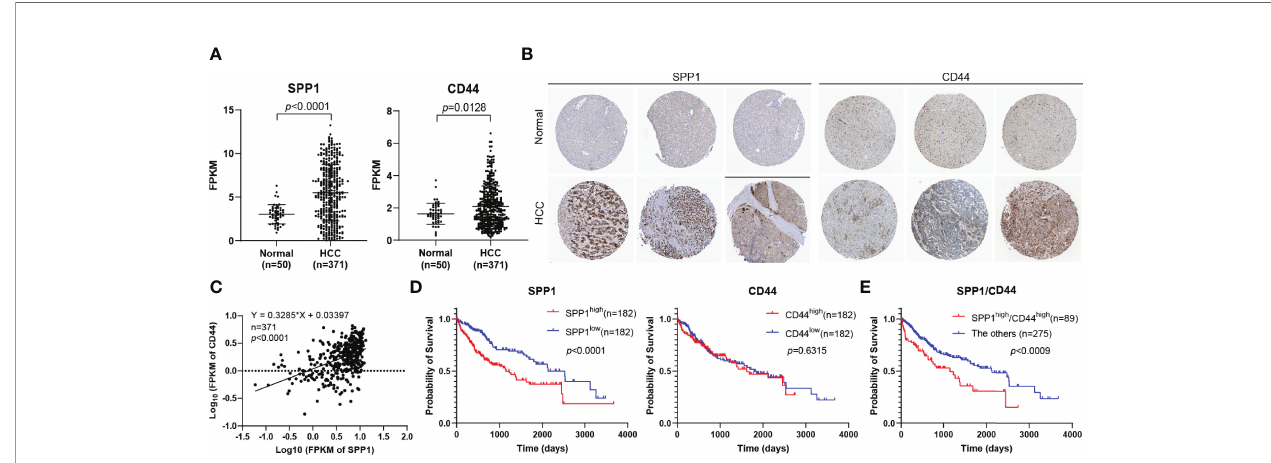
FIGURE 5 | Determination of the expression and prognostic role of SPP1 and CD44 in HCC. (A) The mRNA expression of SPP1 and CD44 in HCC from the TCGA- LIHC database. (B) IHC staining of SPP1 and CD44 in normal and HCC tissues from HPA database. (C) The correlation of the expression of SPP1 and CD44 in HCC (n = 424) from TCGA-LIHC database. (D, E) Kaplan – Meier survival curve of SPP1 and CD44 in HCC from TCGA-LIHC database. HCC, hepatocellular carcinoma; TCGA-LIHC, The Cancer Genome Atlas Liver Hepatocellular Carcinoma; IHC, immunohistochemistry; HPA, Human Protein